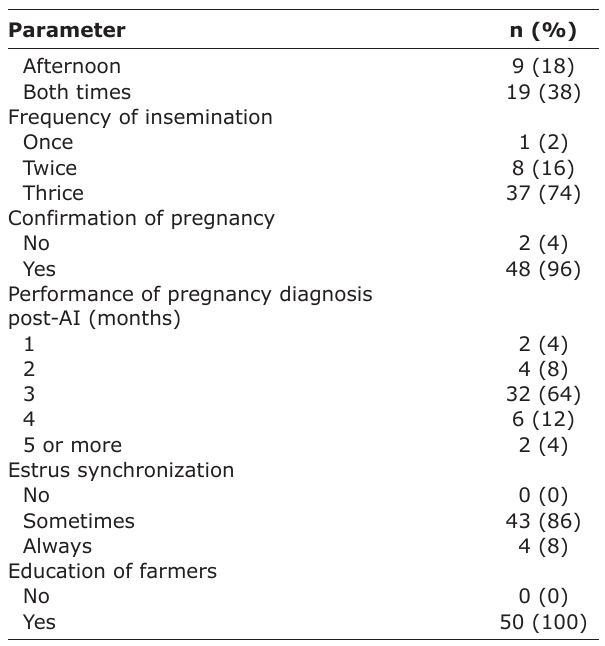
Table-2: AI practices employed by technicians in Eastern Visayas